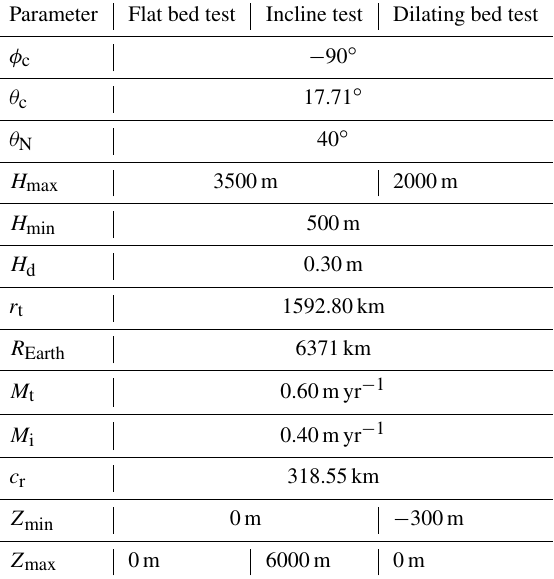
Table 1. Model parameters used in validation